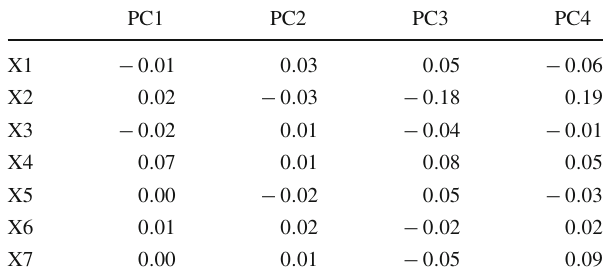
Table 8 Projection on first four PCs found when performing PCA on DY results only (IDs 201, 203 and